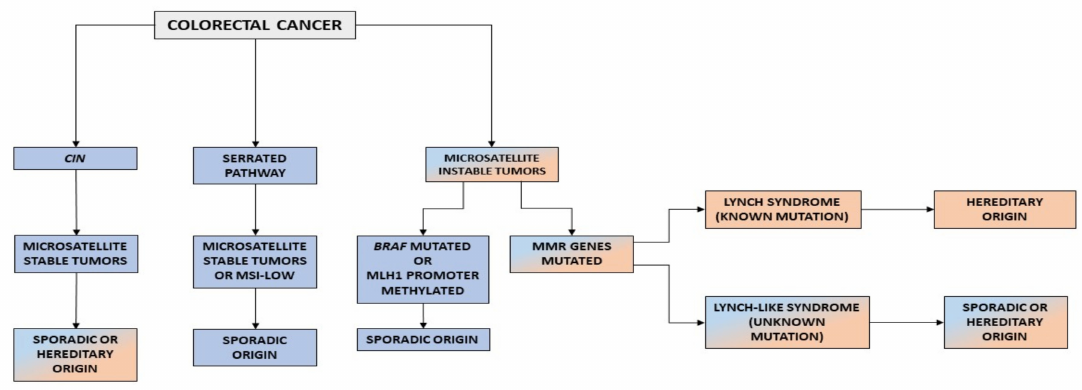
Figure 1. Carcinogenic pathways in CRC. CIN, chromosomal